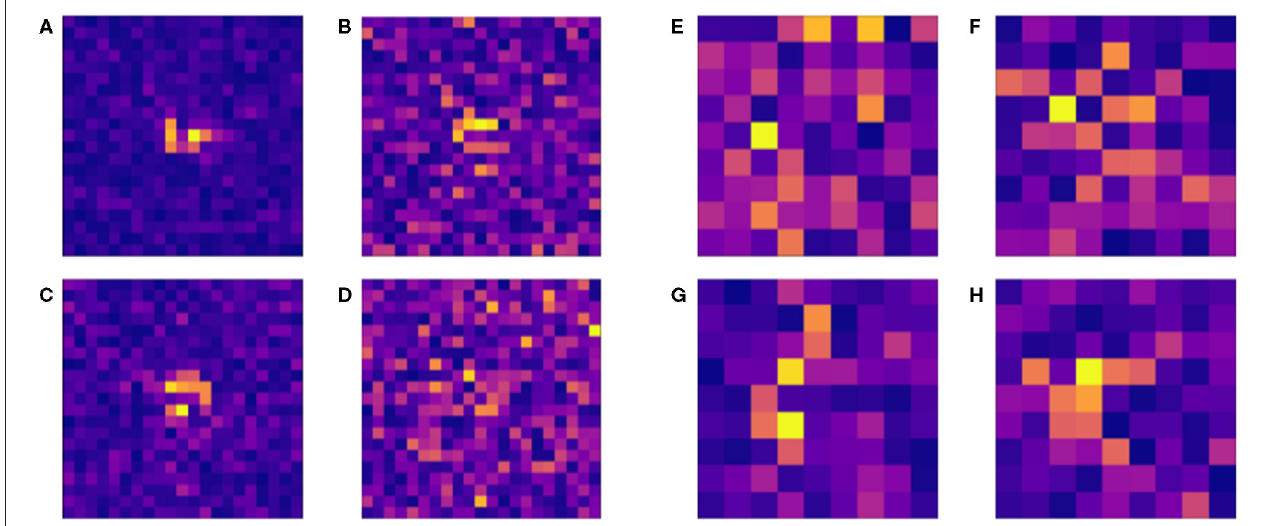
FIGURE 8 | Example saliency maps for a selection of 21 × 21 (A–D) patterns classified by a neural network with zero hidden layers and 1,200 neurons in one layer and 9 × 9 patterns (E–H) with two hidden layers and 1,000 neurons in one layer. The lightness of grid sites indicates their level of contribution towards the decision of the classifier for the different micropatterns tested. In the case of the larger patterns (A–D) , site importance is concentrated around the centre of the pattern, whereas smaller patterns more consistently use sites throughout the pattern to evaluate a structure for selective conduction block. This supports the conclusion that the vast majority of these proarrhythmic phenomena take place on smaller spatial